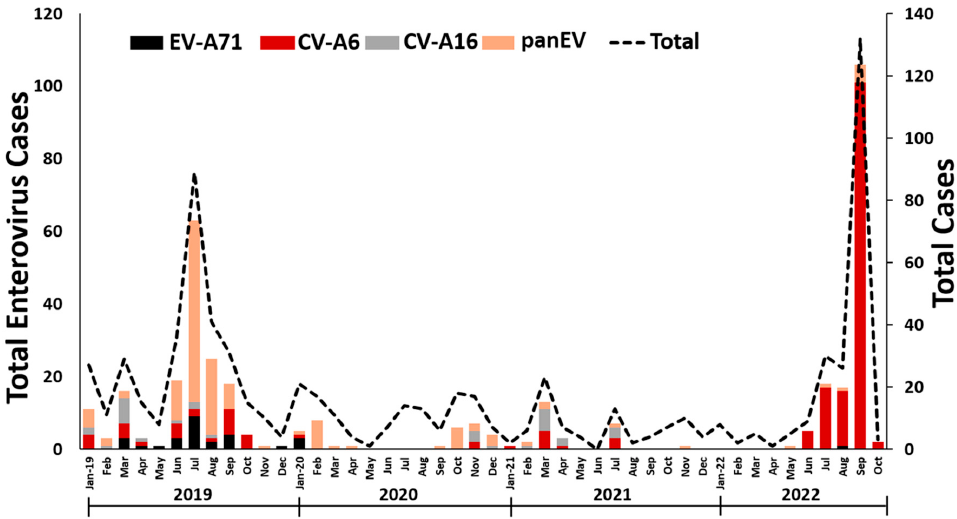
Figure 1. Temporal distribution of enteroviral infections, by epidemiological month, Thailand, 2019–2022 (n =